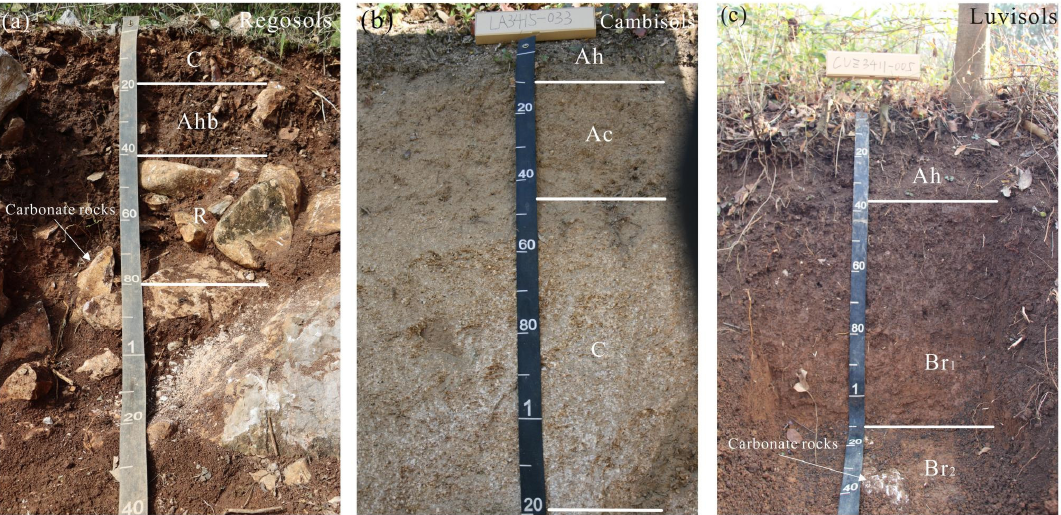
Figure 2. Diagram showing the typical profiles of Regosols ( a ), Cambisols ( b ), and Luvisols ( c ) in the study area.